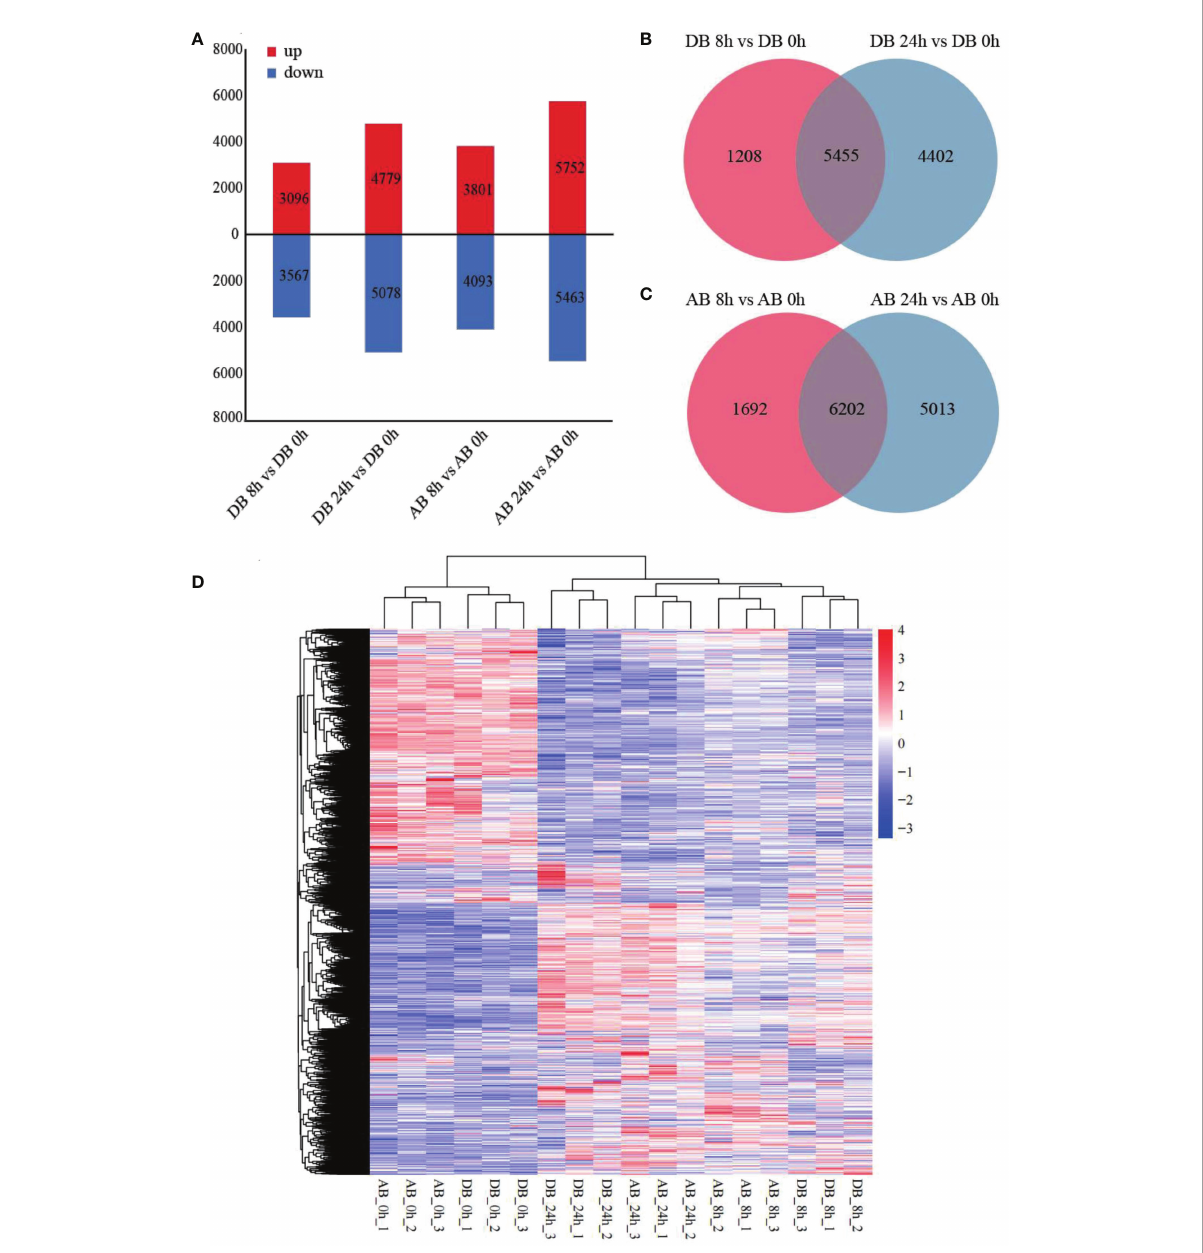
FIGURE 3 DEGs under submergence stress. (A) the number of up- and down-regulated genes in four pair-wise sampling stages, including DB 8 h vs DB 0 h, DB 24 h vs DB 0 h, AB 8 h vs AB 0 h, and AB 24 h vs AB 0 h (B, C) Venn analysis of the DEGs at 8 h and 24 h of post-submergence-stress induction as compared to control in Dianbei (B) , and Anba (C) . (D) the heatmap shows the respective expression levels of DEGs in each sample group, based on the average FPKM of biological replicates. The y-axis shows the cluster dendrogram of DEGs, and the x-axis shows the sample